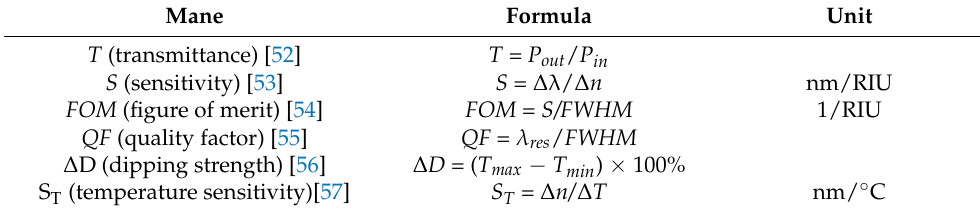
Table 1. Basic formulas used in this work. Mane Formula Unit T (transmittance)